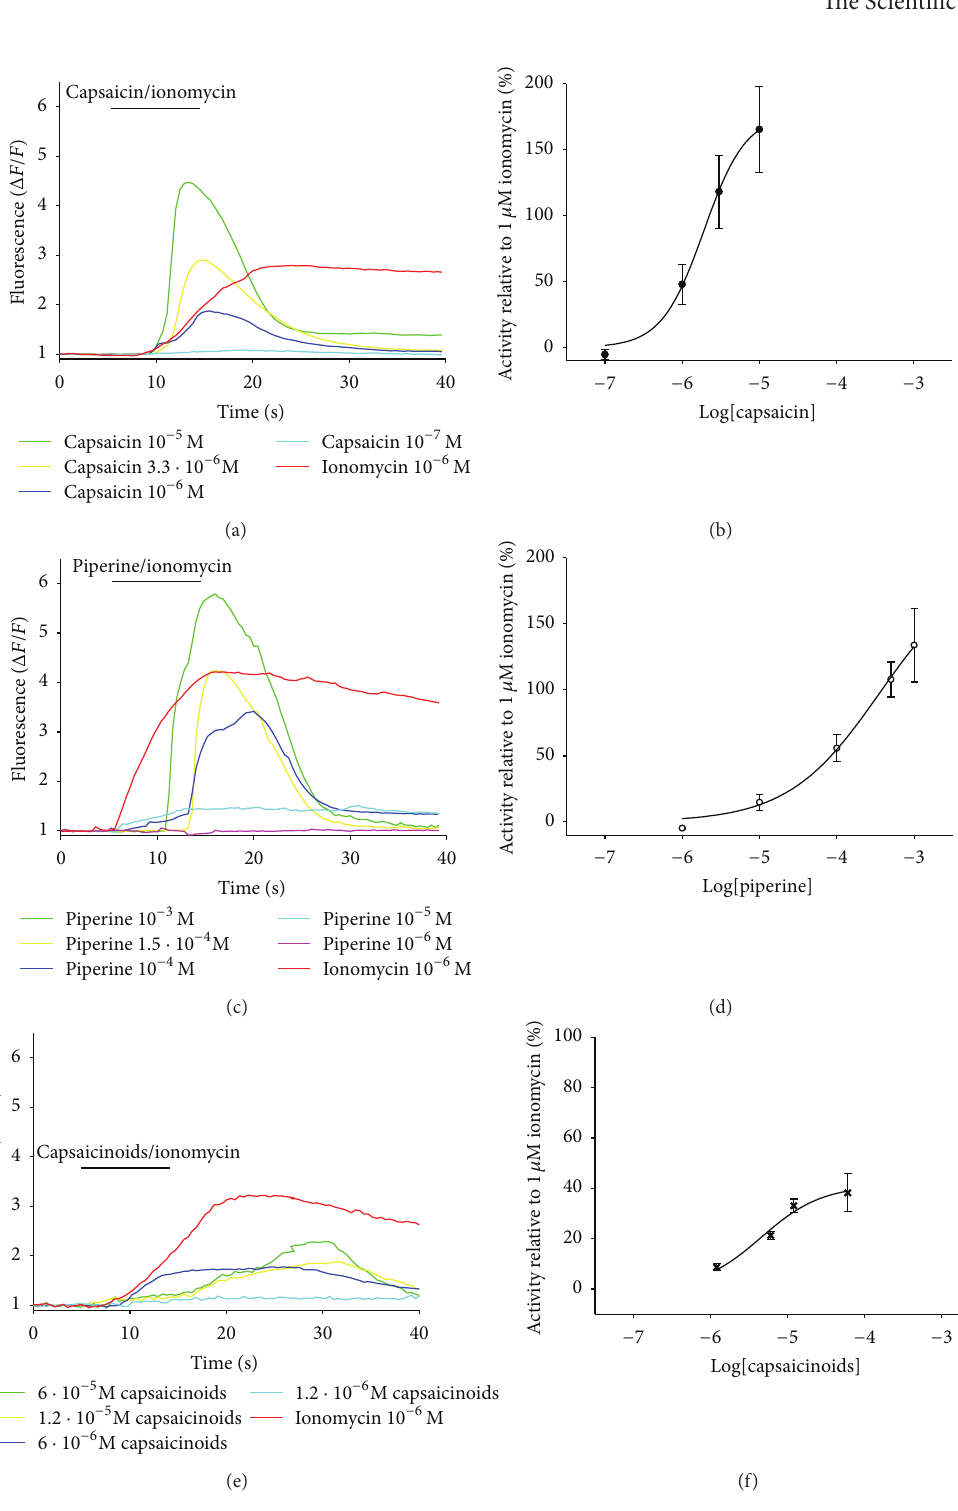
Figure 2: Calcium transients and dose-response curves. The means of measurements for each agonist concentration are plotted as time functions of the increase in fluorescence related to the signal before exposition (a, c, and e); ionomycin was applied at the end of each experiment and its maximum effect was used to normalize the effect of the different agonists and concentrations. The slope showing calcium entrance induced by capsaicin and piperine exposition (capsaicin 830.1 ± 128.1 relative increase of fluorescence per second and piperine 1238 ± 146.8 relative increase of fluorescence per second) (a, c) is sharper than the slope showing calcium entrance induced by natural capsaicinoids exposition (184.6 ± 17.39 relative increase of fluorescence per second) (e). The normalized effect of each concentration is plotted as a dose- response curve for each agonist. Each point represents the mean ± SEM of 3 independent experiments ( 𝑛 = 10 ) (b, d, and